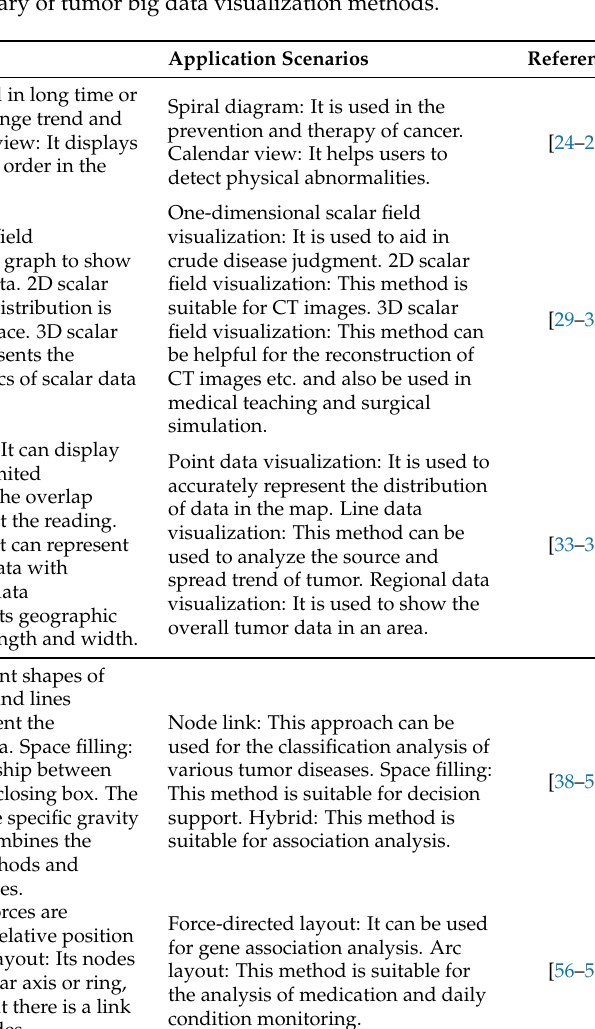
Table 2. Classification and summary of tumor big data visualization